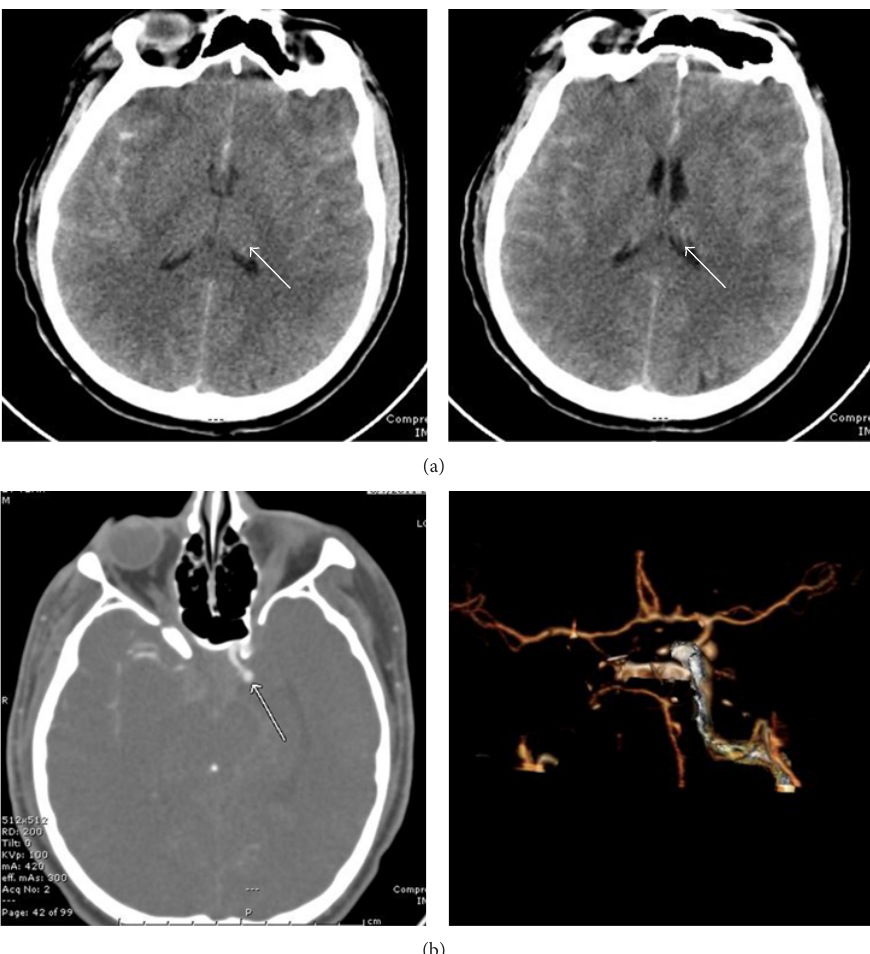
Figure 1: Imaging studies showing spontaneous subarachnoid hemorrhage. (a) CT head without contrast showed subarachnoid hemorrhage withintraventricularinvolvement.(b)CTangiogramofbraindemonstrateda4-5